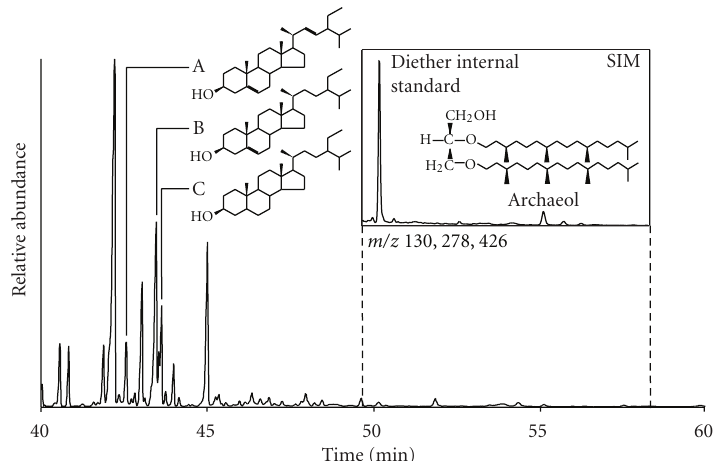
Figure 2: Partial total ion current (TIC) chromatogram of typical biomarker distribution at Caeau Ton-y-Fildre in simple lipid fraction. Inset: Partial chromatogram of selected ion monitoring (SIM) of m/z 130, 278, and 426 showing occurrence and structure of archaeol. A, 24-ethylcholesta-5,22-dien-3 β -ol; B, 24-ethylcholest-5-en-3 β -ol; C, 24-ethyl-5 α -cholestan-3 β